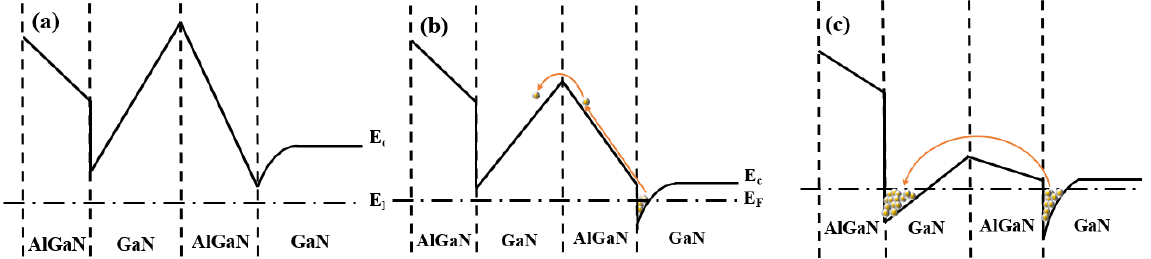
Figure 2. The band structure diagram of the GaN/AlGaN heterojunctions of ( a ) not contacted, ( b ) lower channel contacted, and ( c ) both channels contacted.